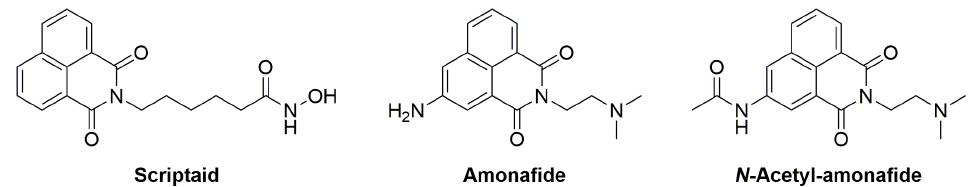
Figure 1. Examples of 1,8-naphthalimides in medicinal chemistry.